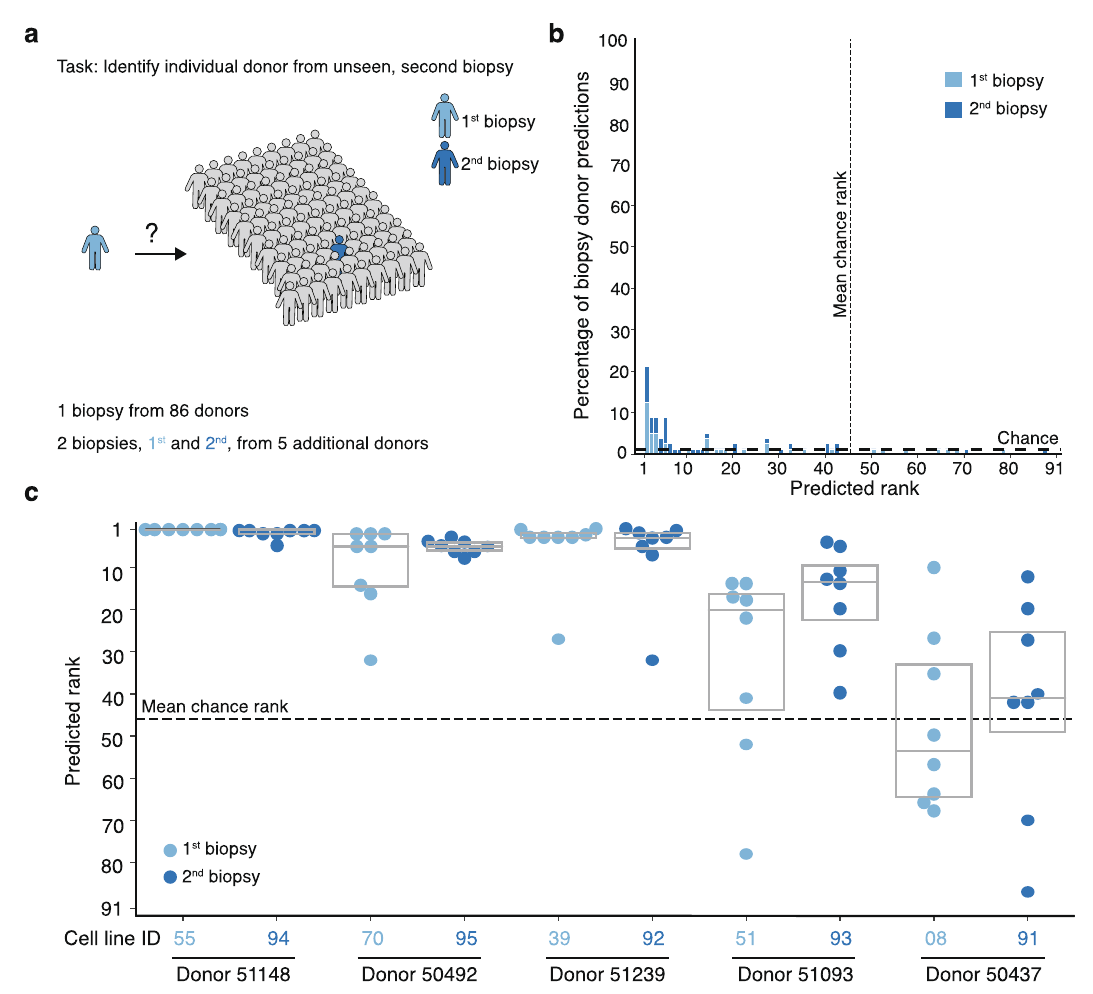
Fig. 4 Donor-speci fi c signatures revealed in analysis of repeated biopsies from individuals. a The 91-way biopsy donor classi fi cation task uses a cross- validation strategy with held-out cell lines, and also held-out batch and plate layout as in Fig. 3a. b Histogram and c box plots of test set cell line – level predicted rank among 91 biopsy donors of the 8 held-out batch/plate layouts for 10 biopsies ( fi rst and second from 5 individuals) assessed, showing the correct donor is identi fi ed in most cases for 4 of 5 donors. Dashed lines denote chance performance. Box plot components are: horizontal line, median; box, interquartile